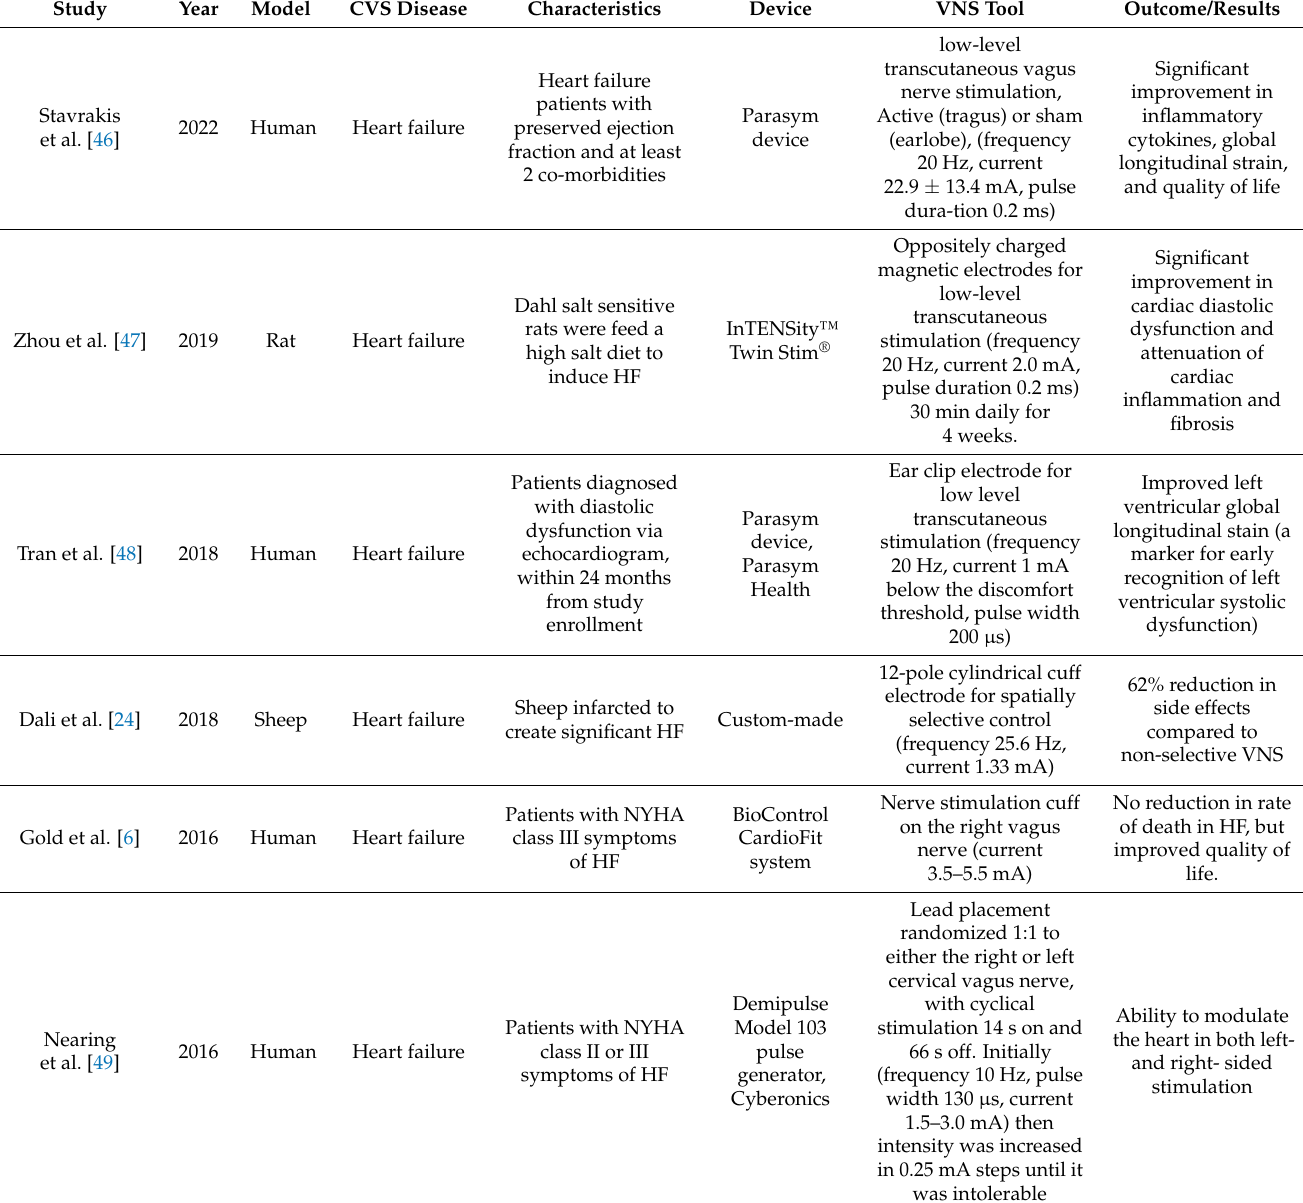
Table 4. Studies on VNS usage for heart failure (HF). (EF—Ejection Fraction, N/A—Not Available, NECTAR-HF—Neural Cardiac Therapy for Heart Failure, NYHA—New York Heart Association, VF—Ventricular Fibrillation, VNS—Vagus Nerve